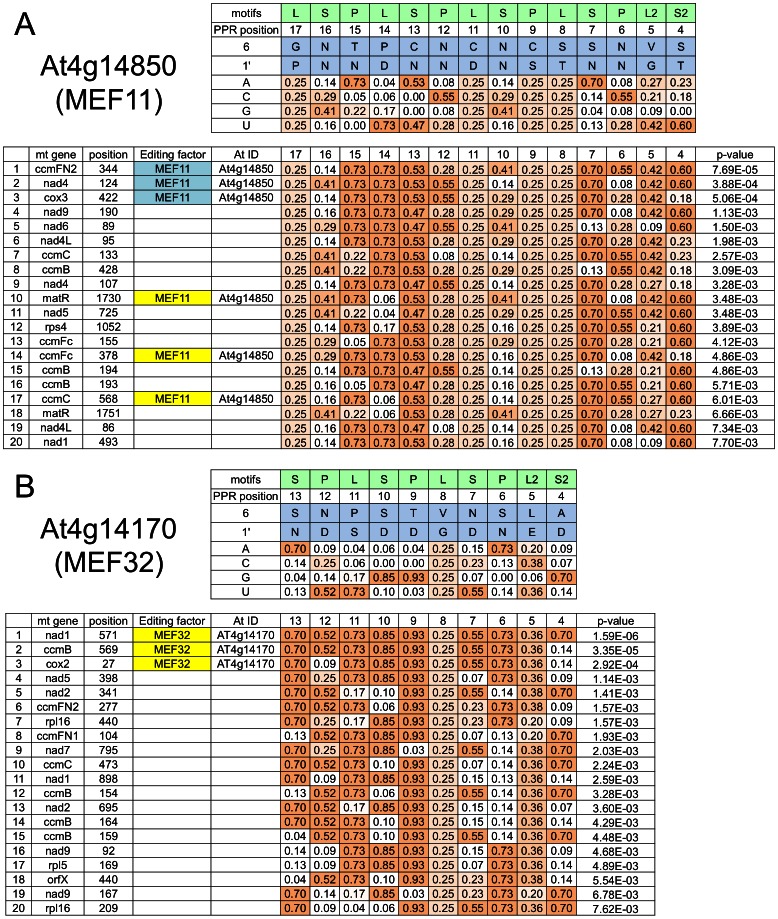
Prediction of nucleotide target sequences for MEF11 and the novel RNA editing PPR protein MEF32.(A) For MEF11 (At4g14850), the RNA editing sites ranked at positions 1, 2 and 3 out of 430 sites have been previously identified as target sites (shaded light blue) [17]. When we analysed all 20 top ranked editing sites in a MEF11 mutant, sites ranked 10, 14 and 17 turned out to be also targets of MEF11 (shaded yellow). (B) Target sequence predictions for the previously unassigned mitochondrial RNA editing factor encoded by At4g14170 are shown for the top ranked twenty sites. When we investigated these in a T-DNA mutant of the gene At4g14170, the three top ranked sites were identified as bona fide targets, at these nucleotides editing is absent in the mutant. This locus has been accordingly renamed to indicate that it codes for the novel RNA editing protein MEF32. The respective top parts in panels A and B show the PPR motifs considered (shaded light green; including the L2 and S2 elements) and their alignment to nucleotide positions which are counted 3′ to 5′ from the edited C (from right to left, −4 to −17 and −4 to −13, respectively). Amino acid identities at positions 6 and 1′ are given (shaded blue) and the respective scores are shown. In the box below, the locations of the top twenty ranked sites are indicated and the assigned specificity factor is given for experimentally confirmed targets, here MEF11 or MEF32. For each repeat the score at each site is given (shaded ocre with the color intensity reflecting the score) and the p-value of FIMO progaram as shown in the far right column is used for the ranking.